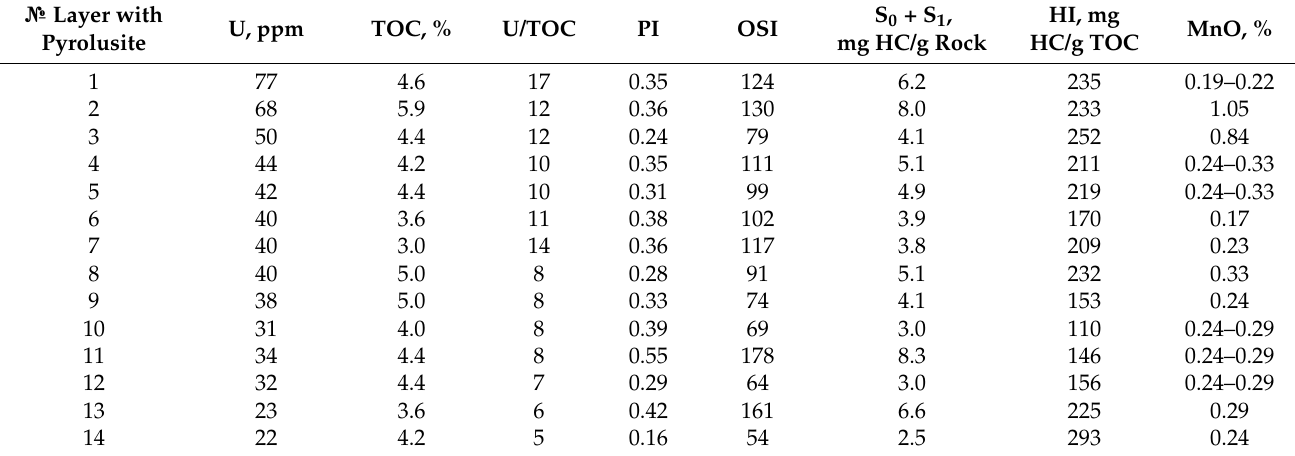
Table 2. Pyrolysis parameters, the concentration of uranium and MnO for the intervals with high uranium content and low organic matter content (Figure